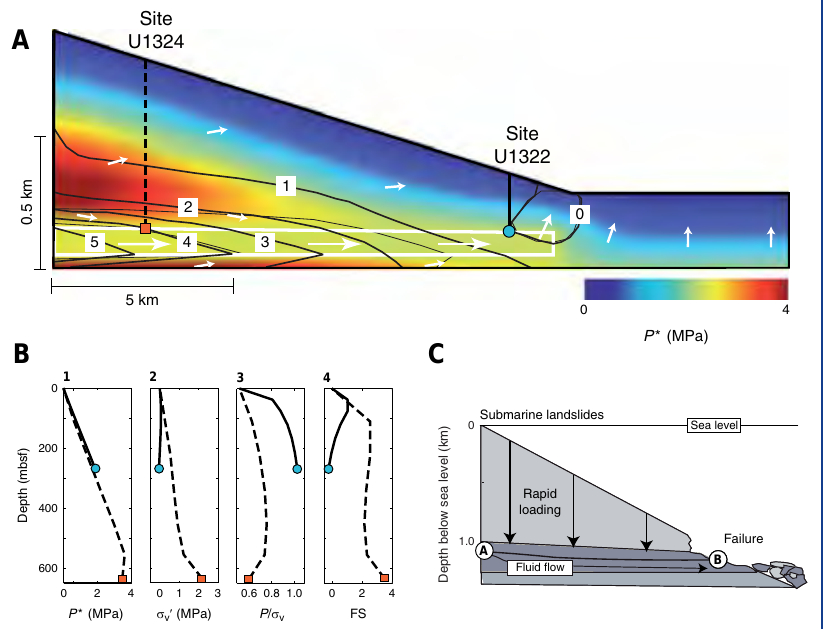
Figure 1. Flow-focusing model approximating conditions in Ursa Basin. [A] Low permeability sediments are rapidly deposited on a high permeability aquifer (outlined in white). Sedimentation rate decreases from left to right, resulting in fi nal wedge-shaped geometry. Rapid sedimentation generates overpressure (P*; color contours) that is greatest on the left (red) side of the picture. Flow is driven laterally (left to right) along the aquifer and is expelled at the toe of the slope where the aquifer ends (white arrows). Vertical effective stress (black contours) is lowest on the right side of the picture. [B] Predicted overpressure profi les where overburden is thick (Site U1324) and thin (Site U1322). (1) Overpressure at Site U1322 is slightly greater than at Site U1324 for equivalent depths. (2) Vertical effective stress ( σ v ´) is much lower at Site U1322 than at Site U1324. (3) Pore pressures (P) equal overburden stress ( σ v ) at Site U1322. (4) Slope failure is predicted by infinite slope analysis near Site U1322 for FS < 1. FS relates failure-driving stress to available shear strength for shallow failures. [C] Model parameters: low permeability mudstone k v < 5 × 10 –8 m 2 and k h < 5 × 10 –16 m 2 ; aquifer permeability k h = k v 5 × 10 –14 m 2 ; maximum sedimentation rate = 3.5 mm·y -1 ; minimum sedimentation rate = 0.8 mm·y -1 . [C] Drawing of how fl ow focusing drives slope